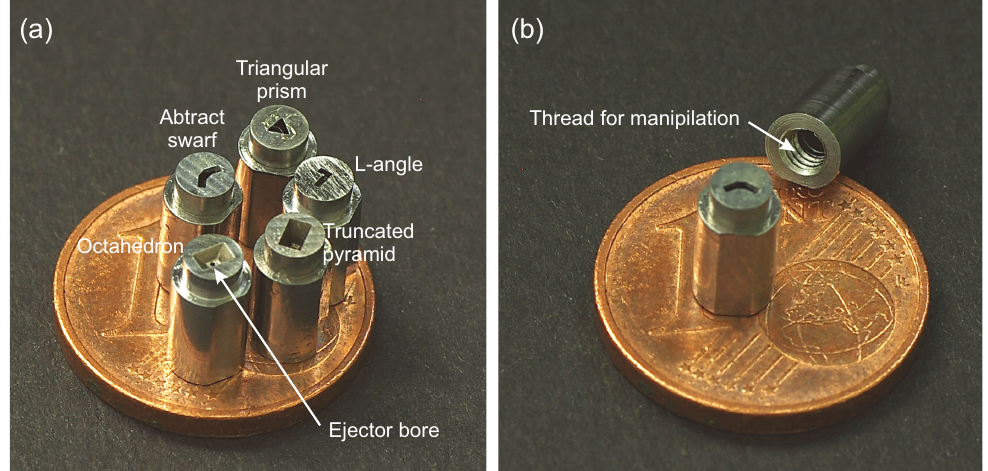
Figure 4. Stamps: ( a ) Each one carrying a cavity of one of the five test particle designs on the front side. ( b ) Screw thread on the back side for handling and fixation in the molding